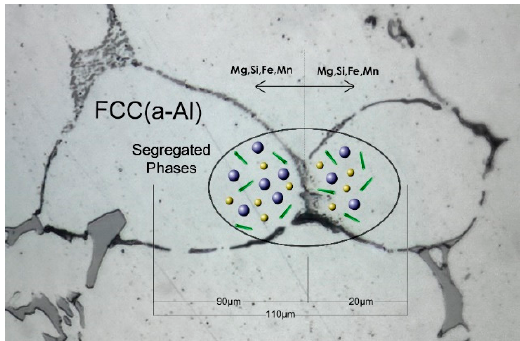
Figure 1. Calculation domain of the Dual-Grain Model consisting of two half-grains with sizes 90 and 20 μ m. Total region size is 110 μ m.